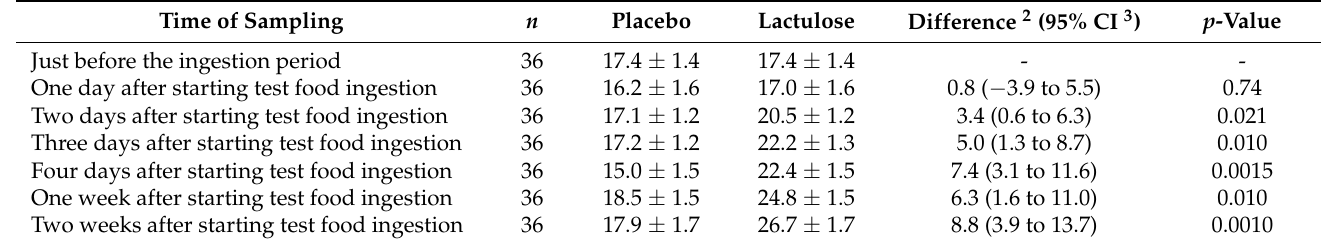
Table 3. Transition in the percentage of genus Bifidobacterium in the faecal microbiome 1